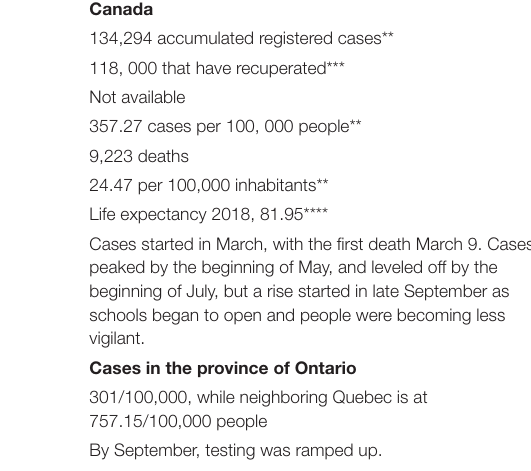
TABLE 1 | Guatemalan and Canadian COVID-19 data September 9, 2020. Data obtained from national